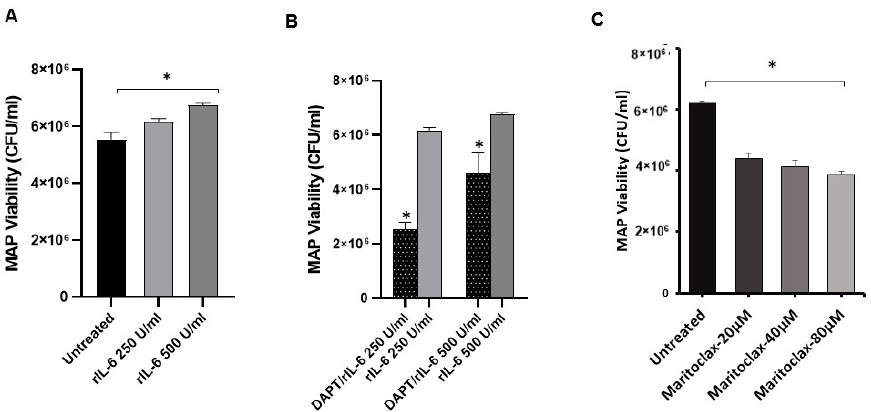
Figure 5. E ff ect of rIL-6, DAPT and Maritoclax on MAP viability. ( A) : MAP viability was measured following treatment with rIL-6 (0–500 U / mL) in infected macrophages. ( B) : MAP viability was measured in infected macrophages which were treated with DAPT (30 µ M) then with rIL-6 (0–500 U / mL). ( C ) MAP viability was measured in infected macrophages which were treated with Maritoclax (0-80 µ M). MAP viability was measured using Live / Dead TM Bacl ight TM bacterial viability assay and represented as (CFU / mL). All experiments were performed in triplets. Data are shown as mean ± SD, and significance is considered as * p < 0.05.